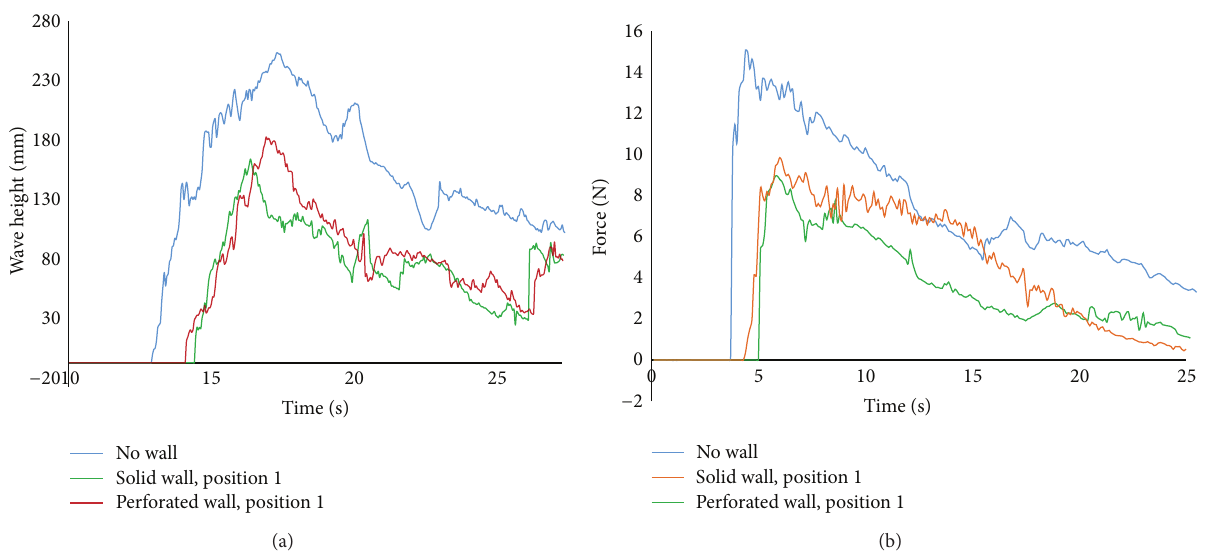
Figure 7: (a) Comparison of wave height time history in position 1. (b) Force time history with solid and perforated sea wall compared with no wall